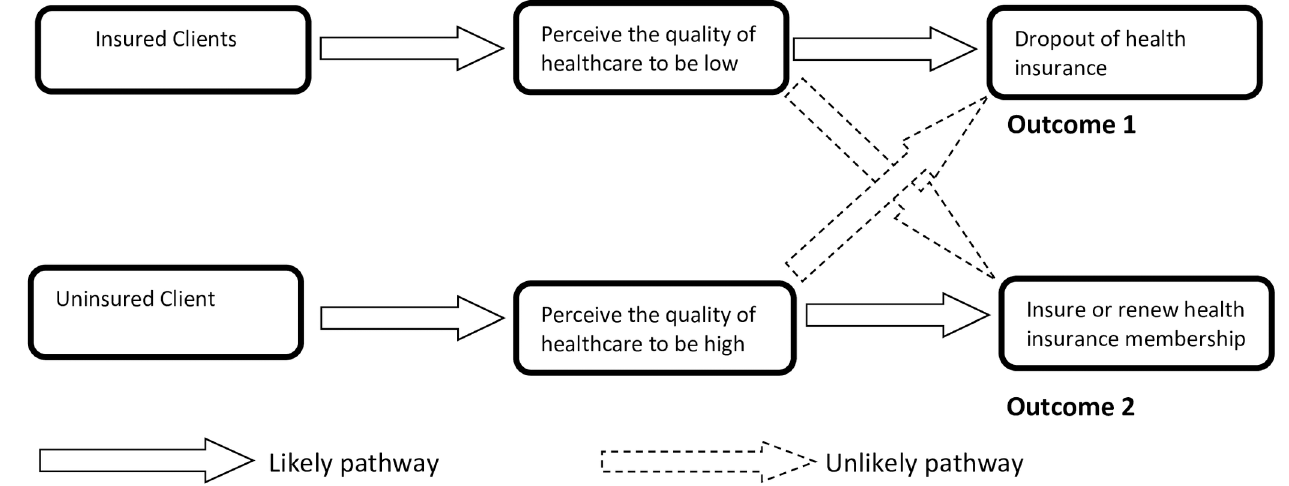
Fig 2. Conceptual frameworkof dependence of quality perceptions on insurance